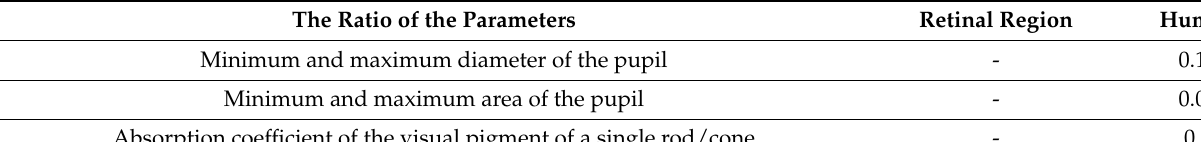
Table 4. The ratio of the parameters of the human